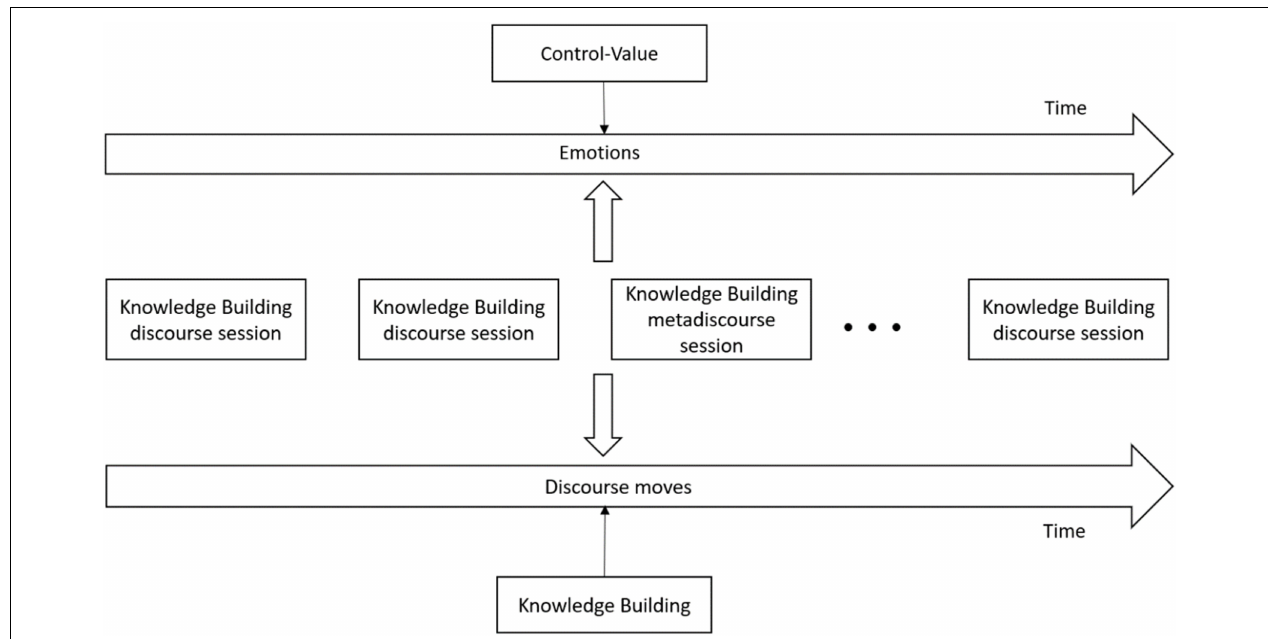
FIGURE 3 | A conceptual framework of discourse move-emotion states in Knowledge Building discourse and metadiscourse sessions over